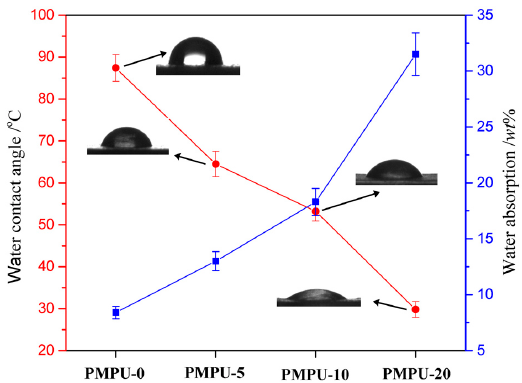
Figure 3. Water contact angle and water absorption of composite films with varying PMEH content.